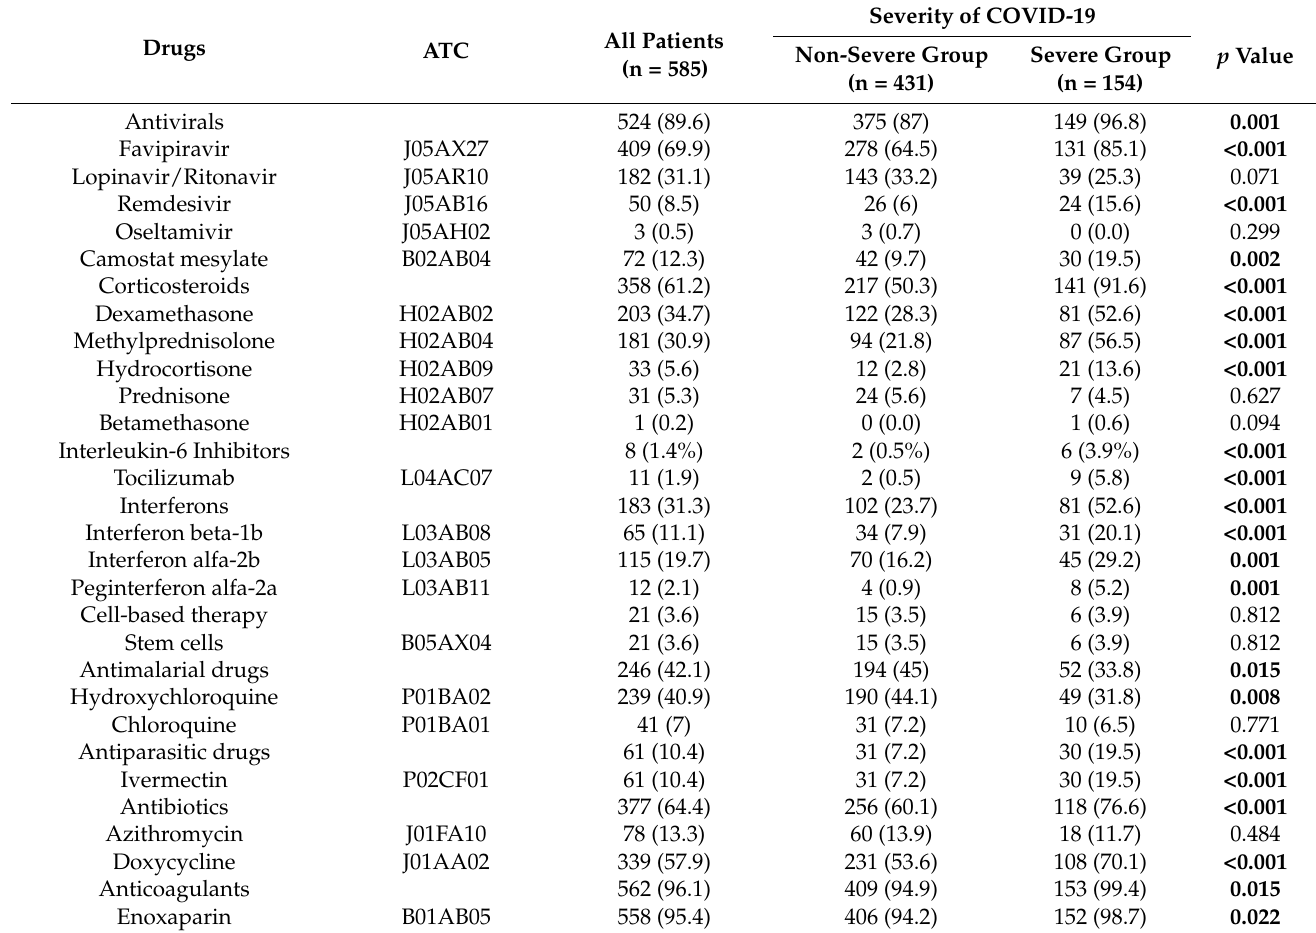
Table 5. Pharmacotherapy of COVID-19 patients stratified by severity of the